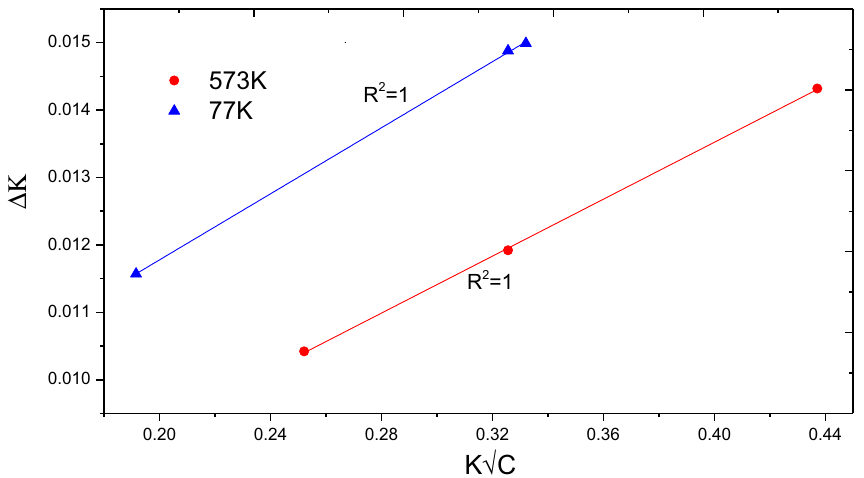
Figure 5. Modified W–H plot for the unirradiated sample and for samples irradiated to 0.2 dpa at varying temperatures.